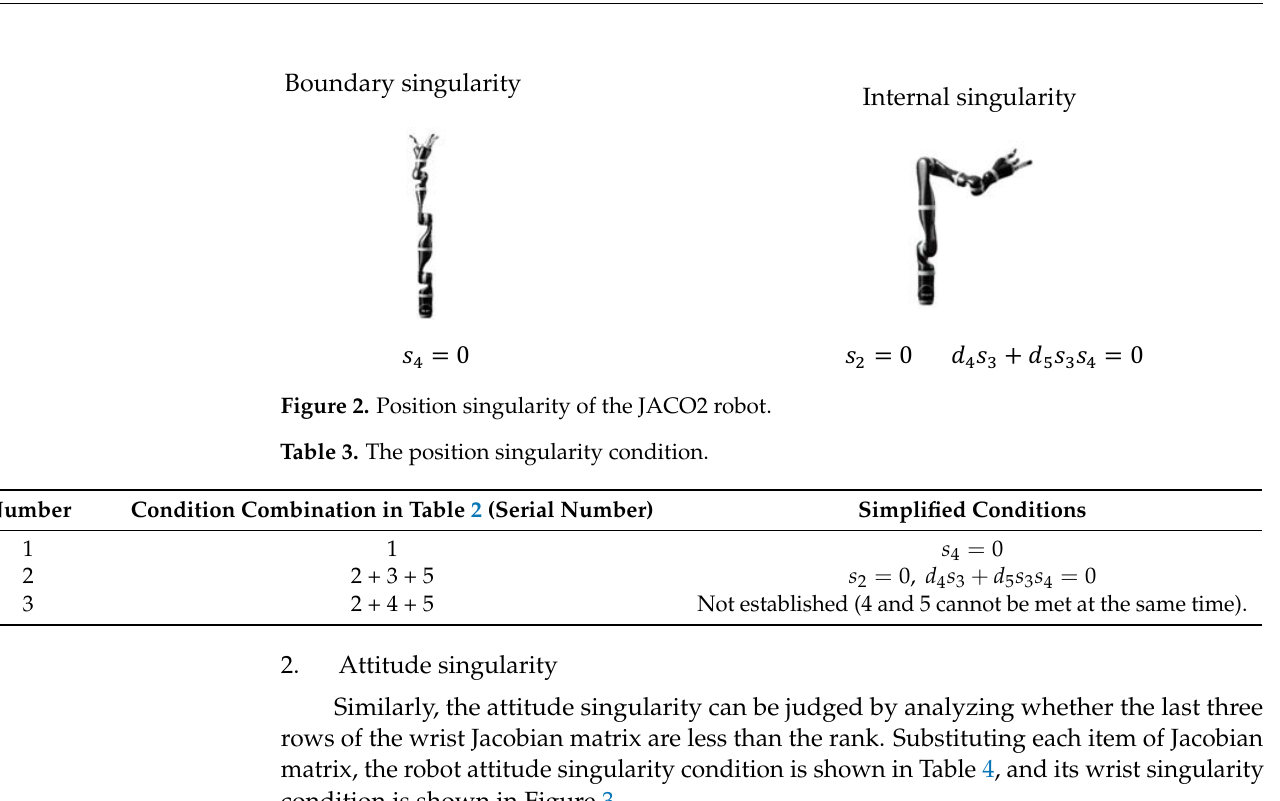
√ Table 3. The position singularity condition.